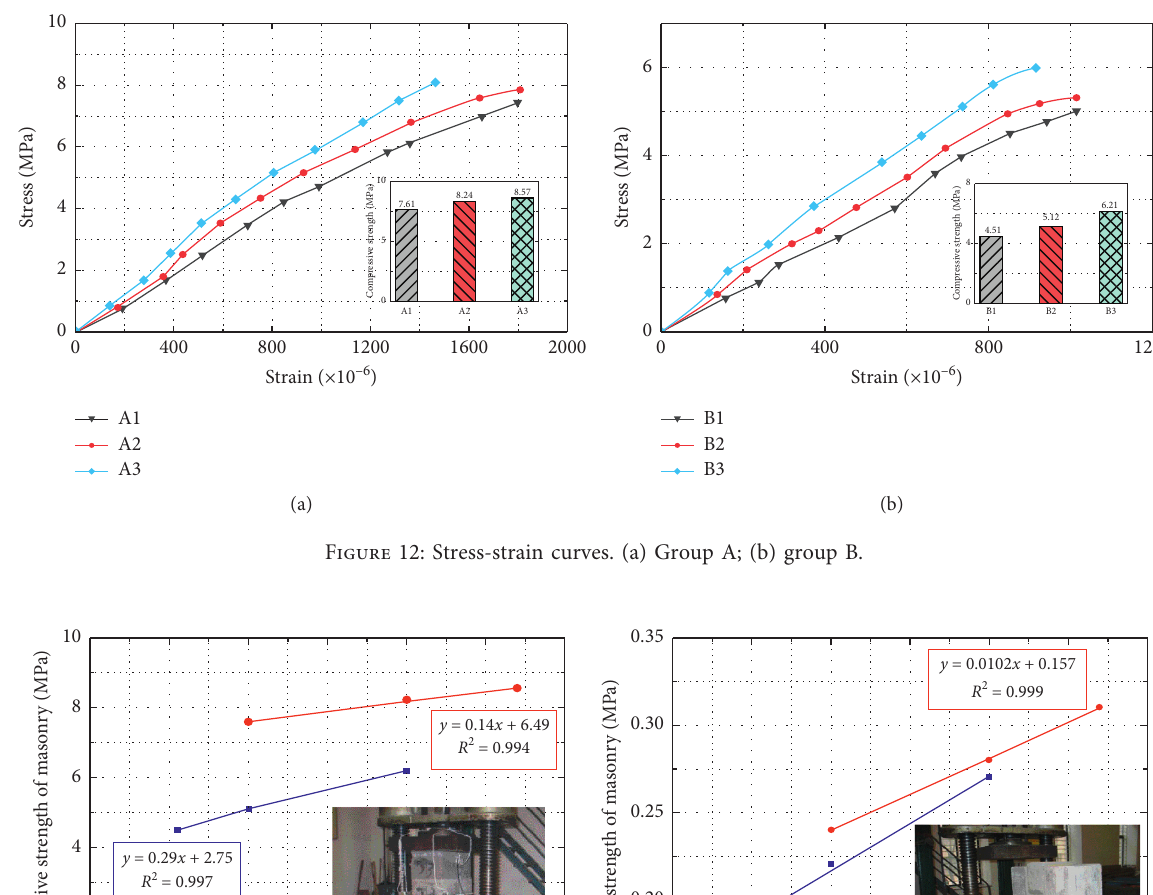
Figure 13: Effect of RCB strength and mortar strength on the RCB masonry strength. (a) Compressive strength; (b) shear